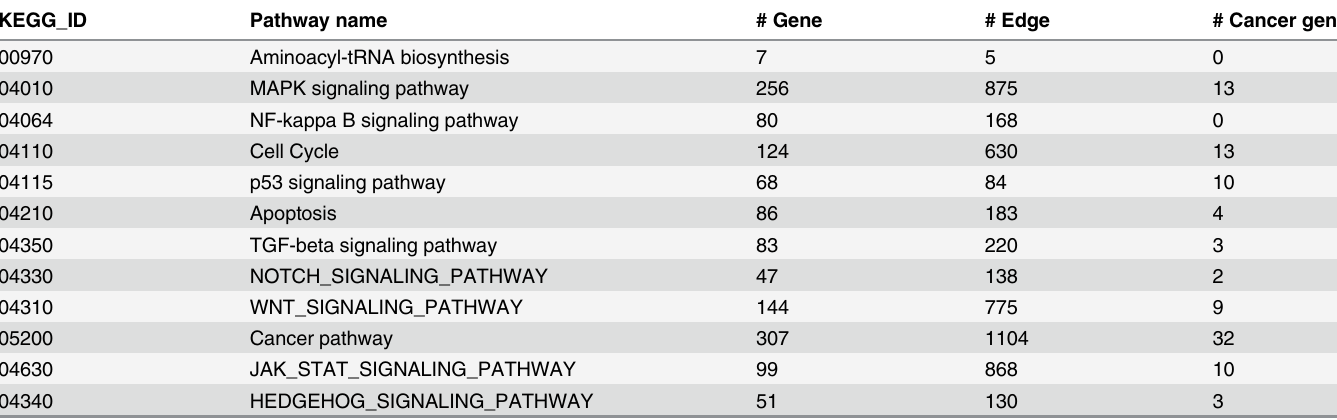
Table 1. 12 important cancer pathways from